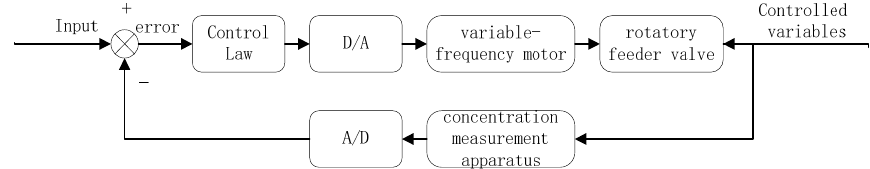
Figure 4. Feedback control block diagram for sand/dust concentration.